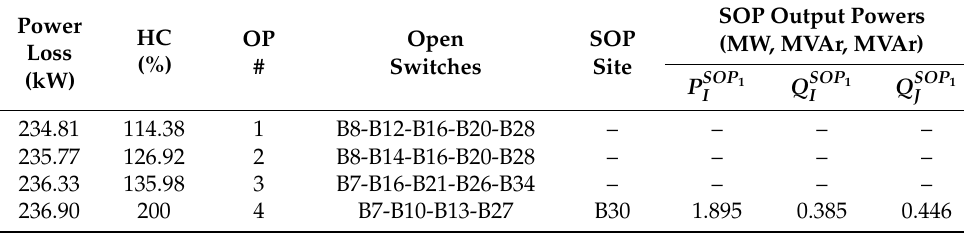
Table 5. Nondominated solutions from MOAIS, Case